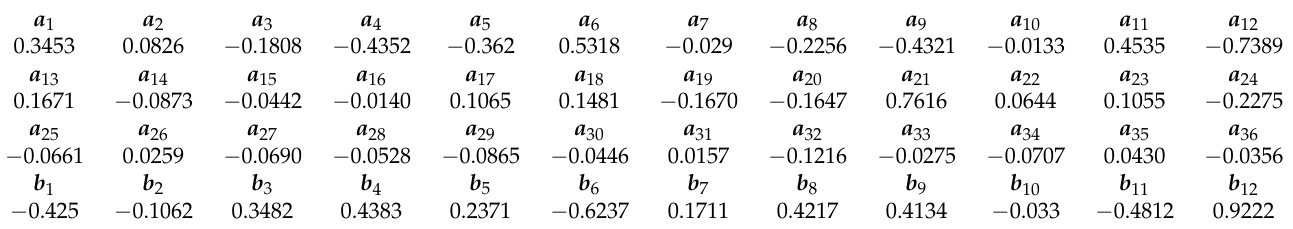
Table 10. Parameters of the ARIMA model of the all-terms group.